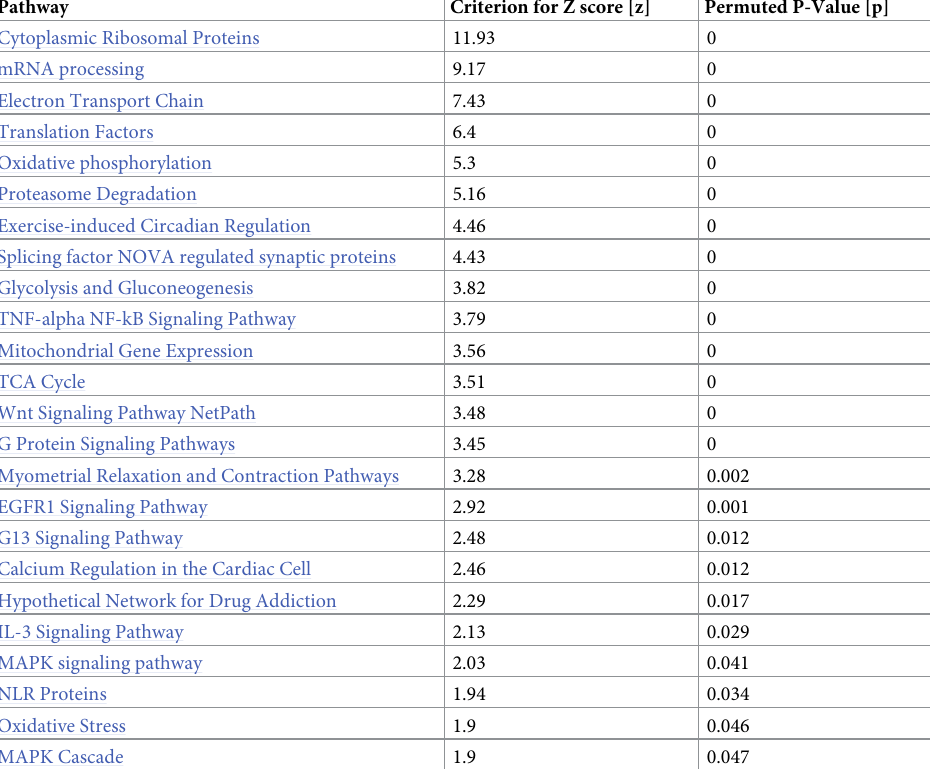
Table 2. Pathway statistics: G1_SGE_vs_control, fold change < 0.25.